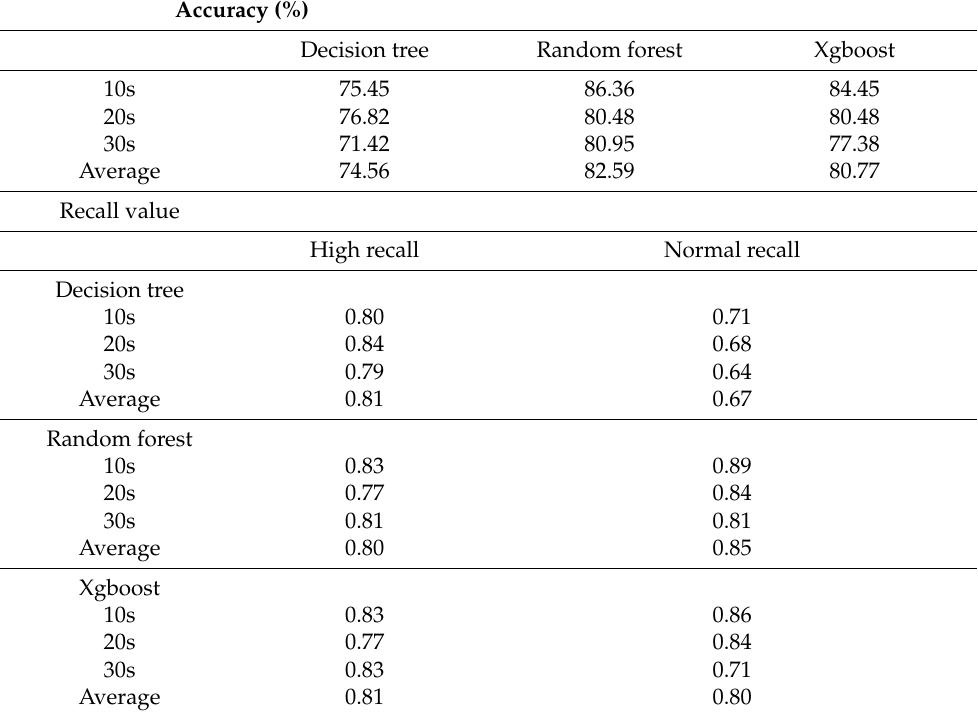
Table 6. Accuracy and Recall Value for Each